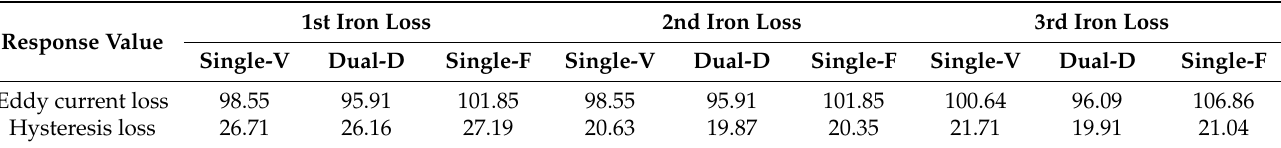
Table 5. Comparison of three rotor structure iron losses in stator using three different calculation method at 6540 rpm and 24 A phase current.